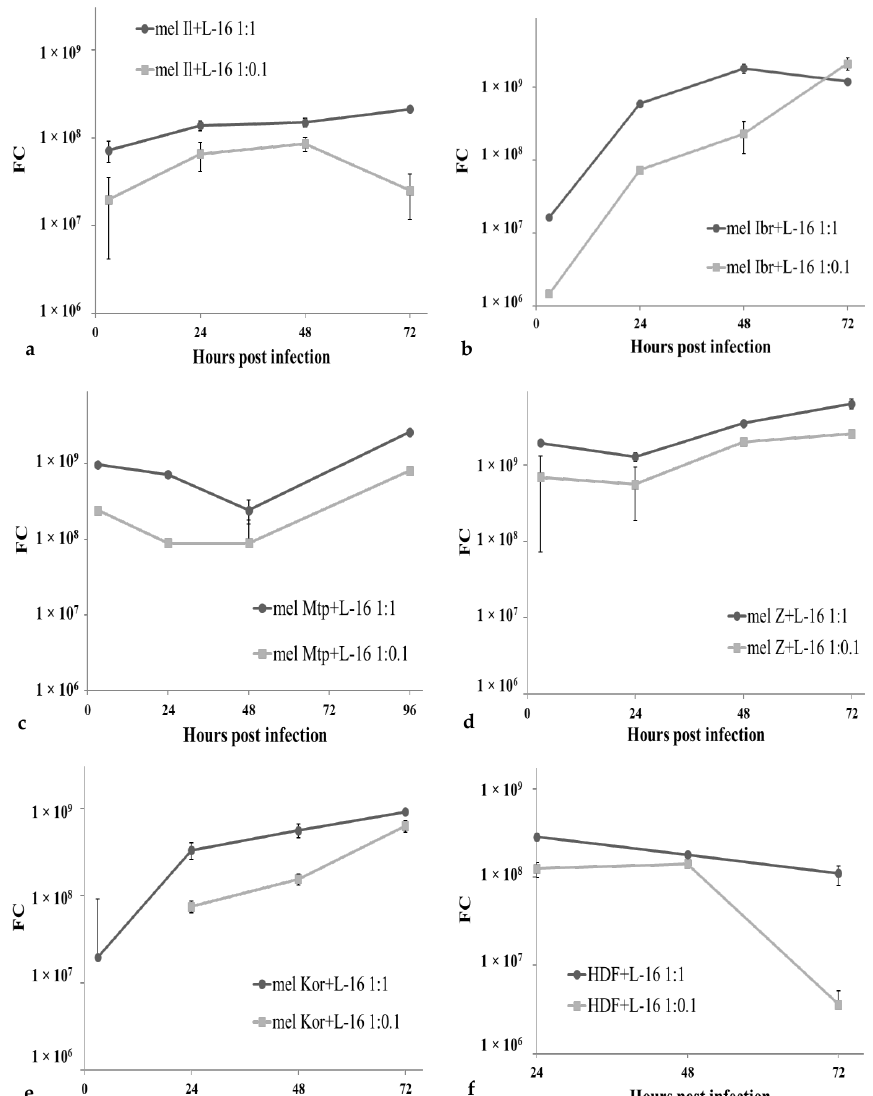
Figure 5. Replication of MV strain L-16 in melanoma cells and fibroblasts. Melanoma cells, mel Il ( a ), mel Ibr ( b ), mel Mtp ( c ), mel Z ( d ), mel Kor ( e ), or HDF ( f ) cells were infected with MV at a MOI of